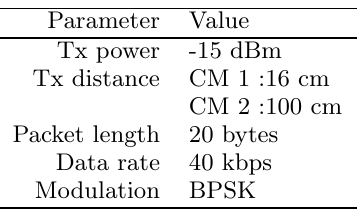
Figure 11: Tx Rate vs Packet delivery ratio evalu- ated with fixed packet length. Measured in CM1